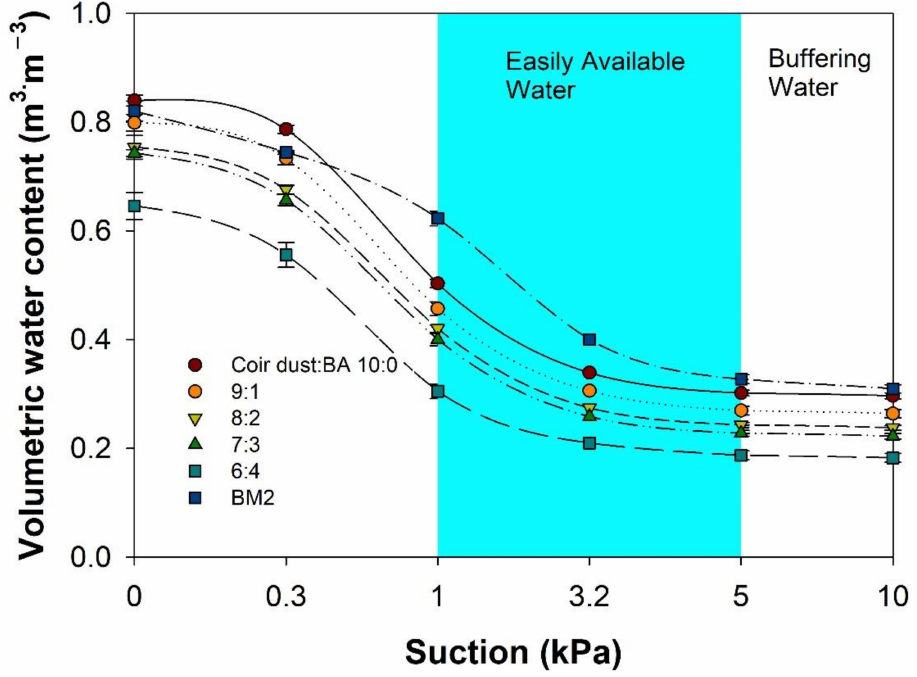
Figure 2. Water retention curve in mixed coir dust and coal bottom ash (BA) substrates and in a commercial germinating mixture